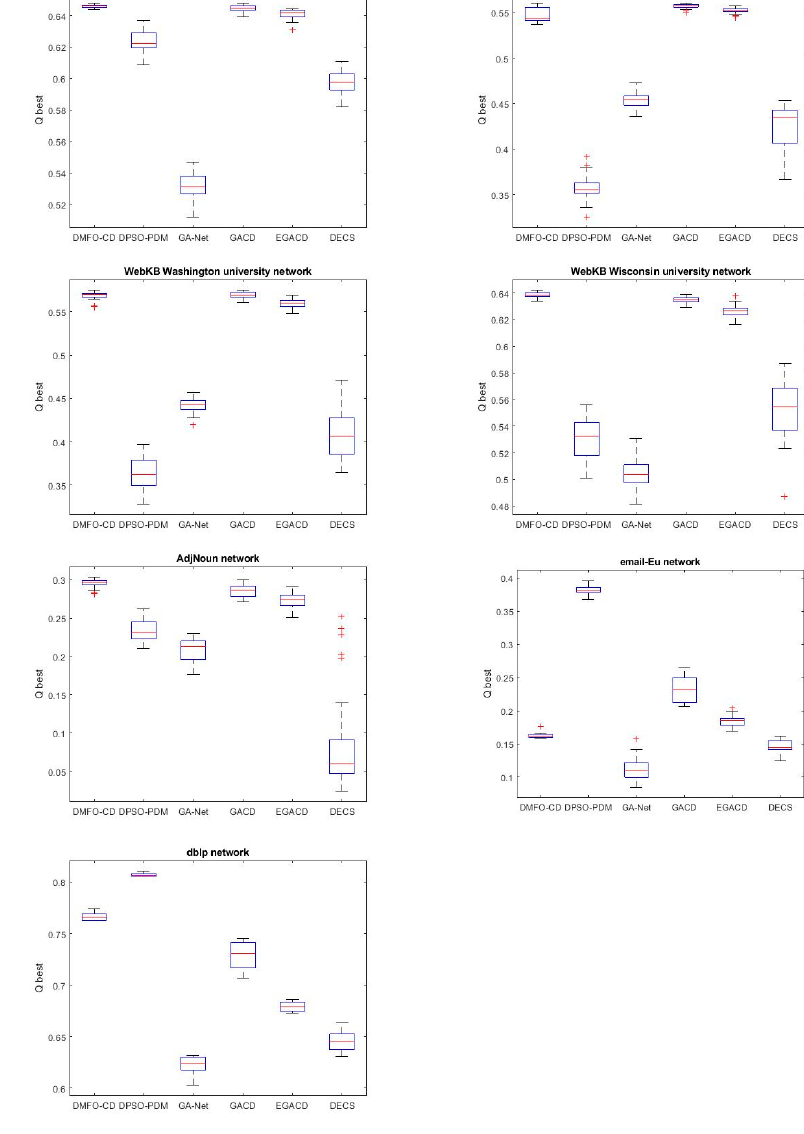
Figure 10. The boxplot of modularity (Q).